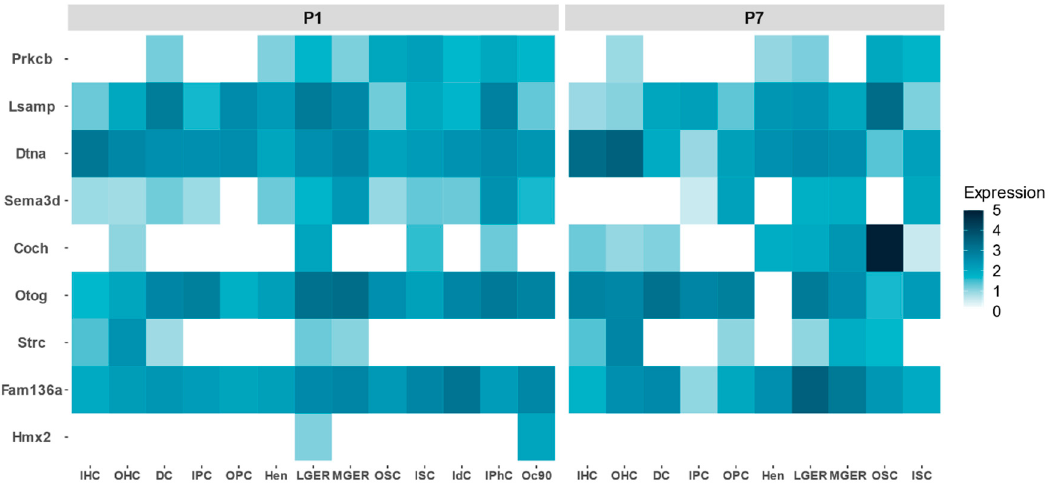
Figure 4. Relative gene expression of candidate genes for FMD in the mouse organ of Corti in postnatal days 1 (P1) and 7 (P7) comparing different cell types: inner hair cells (IHC), outer hair cells (OHC), Deiters’ cells (DC), inner pillar cells (IPC), outer pillar cells (OPC), Hensen cells (Hen), lateral greater epithelial ridge cells (LGER), medial greater epithelial ridge cells (MGER), outer sulcus cells (OSC), inner sulcus cells (ISC), interdental cells (IdC), inner phalangeal cells (IPhC), cells expressing Oc90 (Oc90).